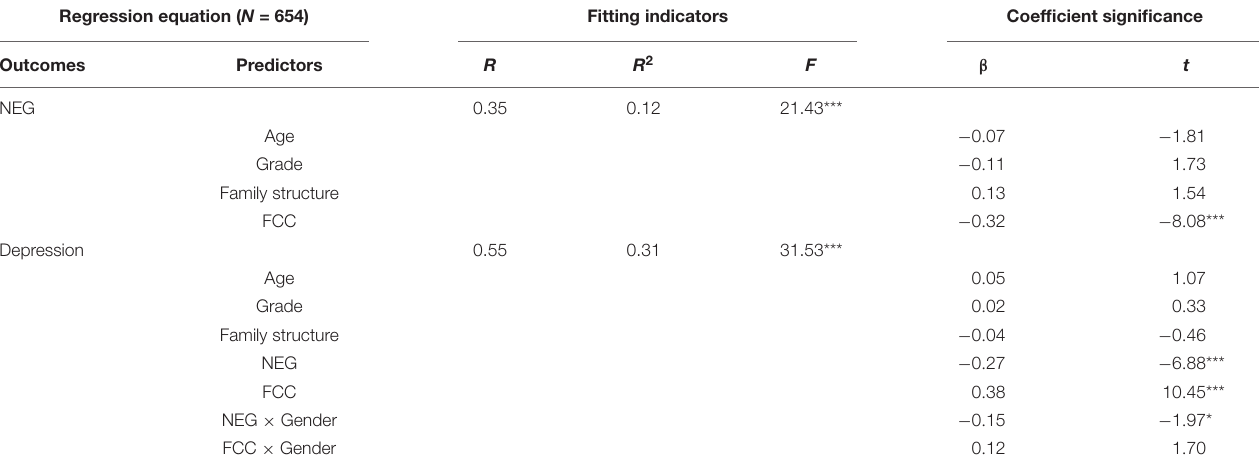
TABLE 7 | Testing the moderated mediation effect of father-child conflict on adolescent depression. Regression equation ( N =